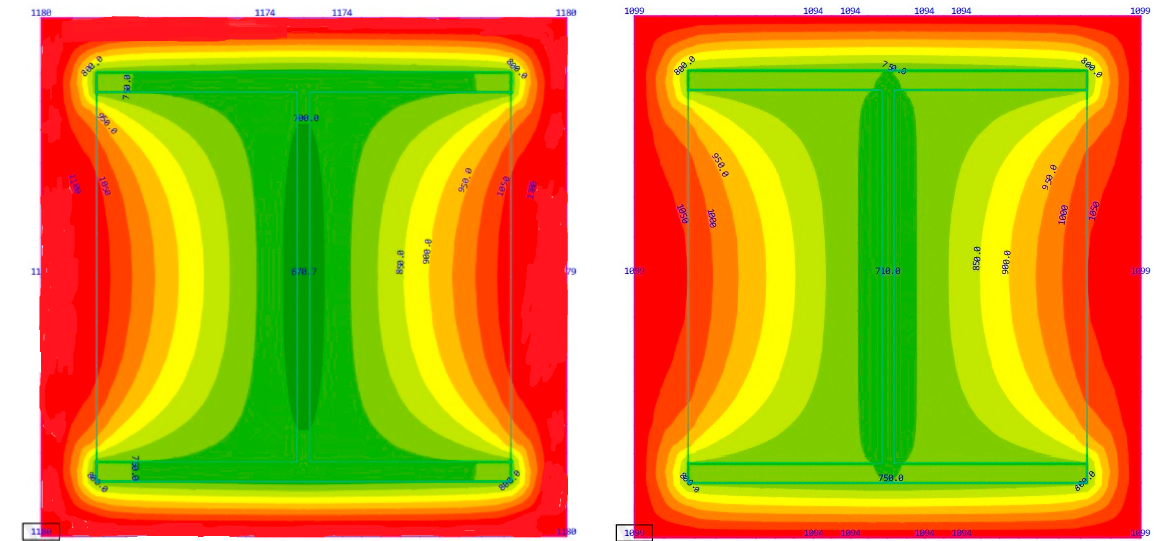
Figure 10. Simulation outcomes for reaching the I-beam critical temperatures in various fire cases; ( left ): standard fire curve, 285 min ( right ): hydrocarbon fire curve, 290 min.